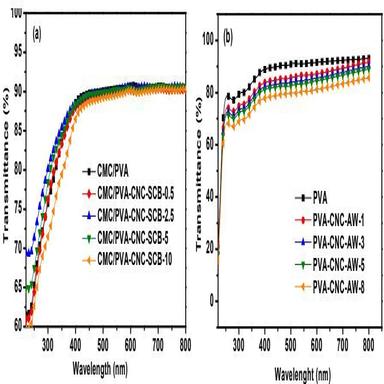
UV-Vis transmittance of (a) neat CMC/PVA and its CMC/PVA-CNC-SCB nanocomposite films and (b) neat PVA and its PVA-CNC-AW